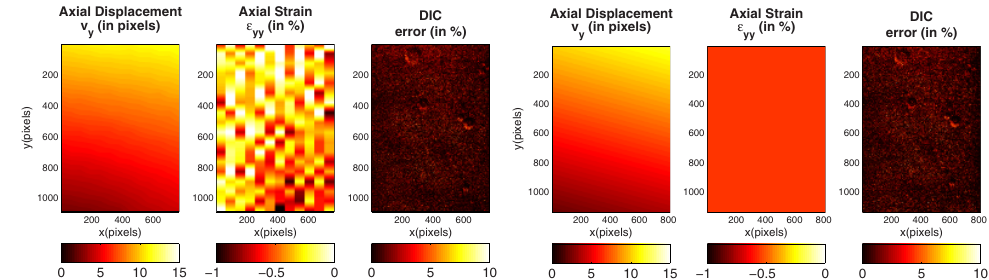
Figure 4. Kinematics measured using the Q4-DIC (left) and uni-DIC (right) approaches for the maximum load in the elastic domain for the compressive test